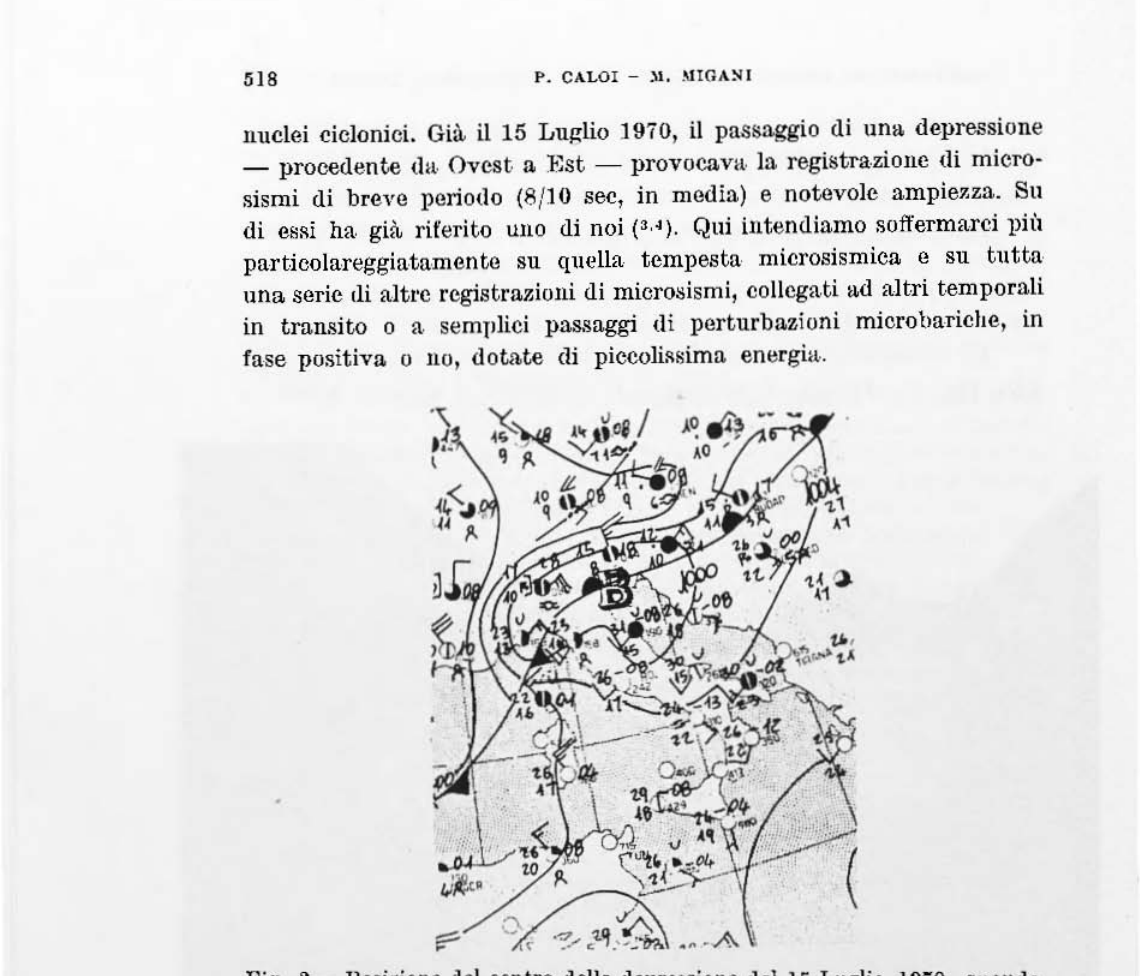
Fig. 2 - Posizionè del centro della Ilepressione Ilel 15 Luglio 1970, qUllIuto, alle ore 18 (T.M.G.)